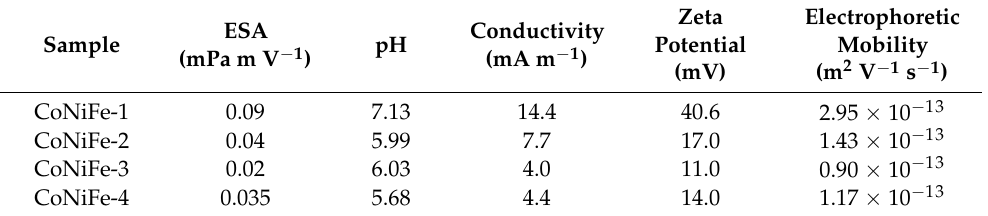
Table 1. Characteristic parameters of the aqueous suspensions of Co-Ni-Fe oxides.